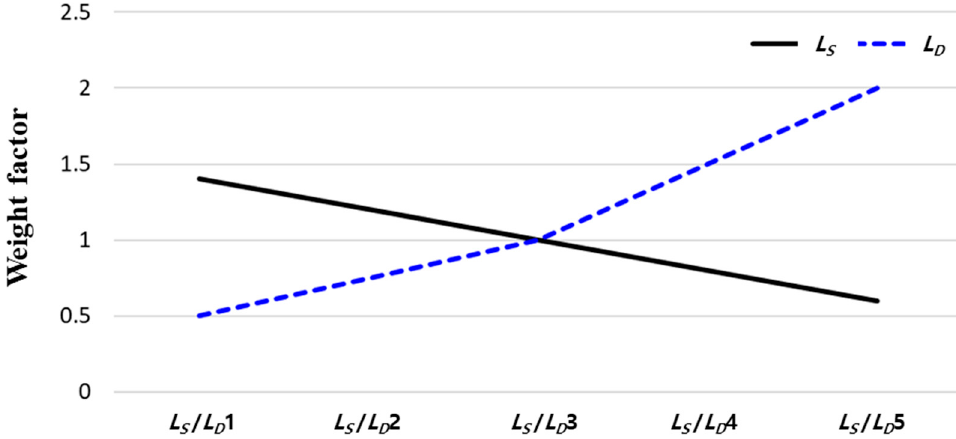
Figure 4. L S and L D weight factors according to experts.